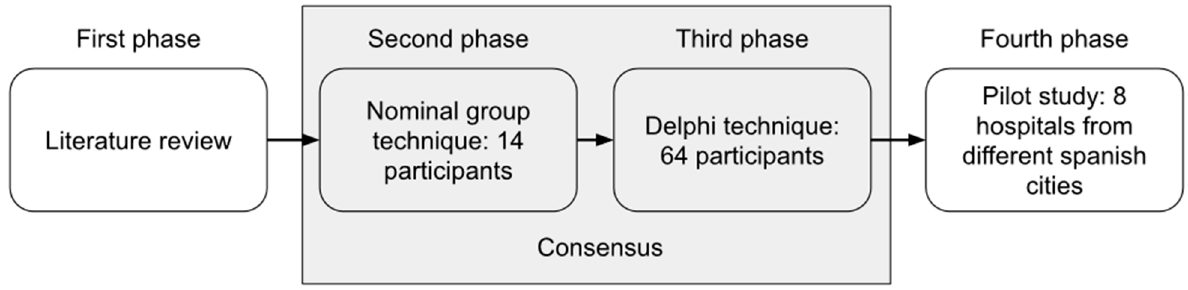
Figure 1. Phases of the study.